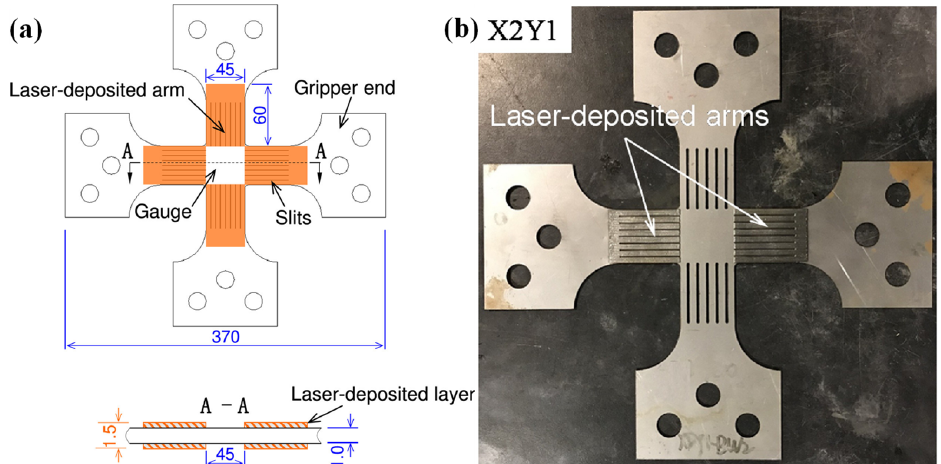
Figure 19. Cruciform specimen with arms reinforced by laser deposition: ( a ) dimensions and ( b ) a laser-deposited cruciform specimen. Reprinted from Ref. [248] with permission. Copyright 2021, Elsevier.